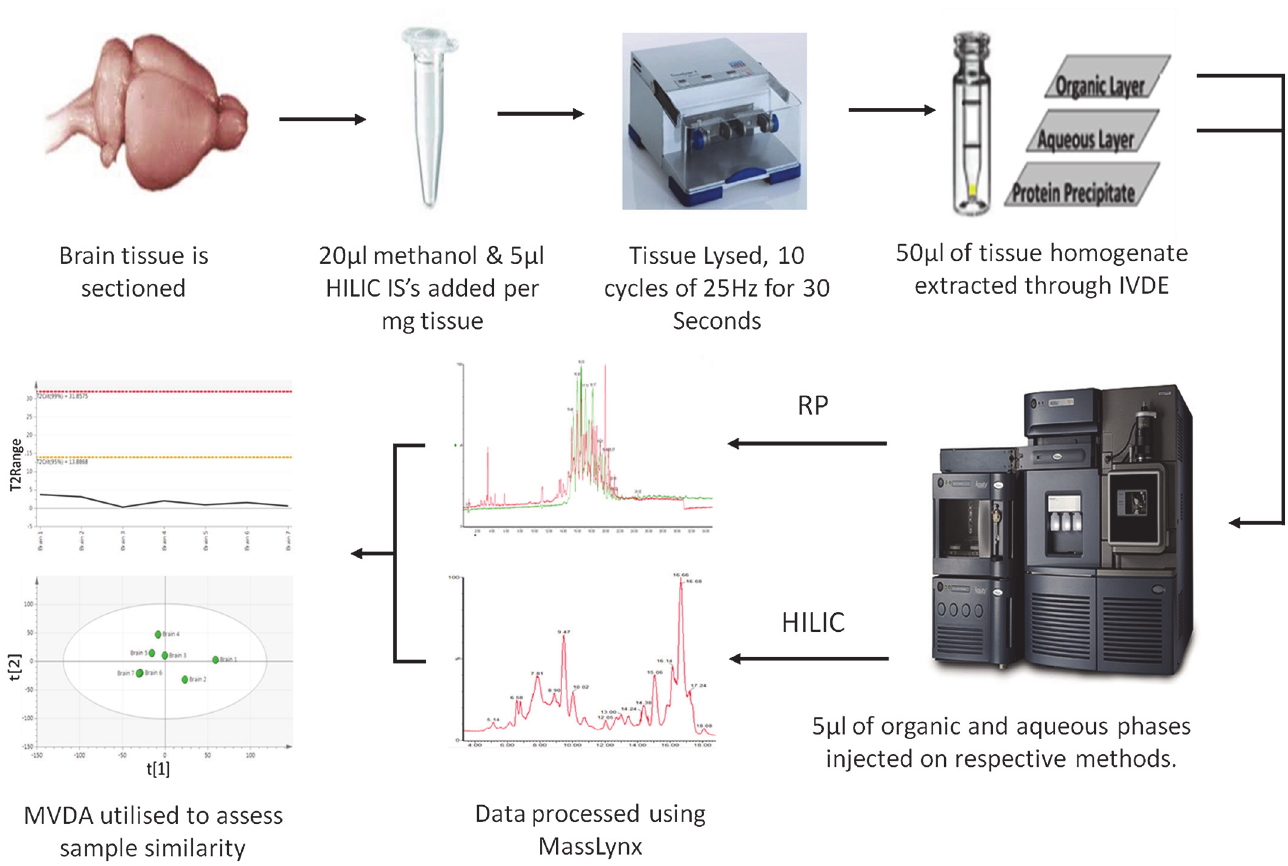
Fig 2. Applied analytical pipeline. Shows the seven steps from tissue sectioning to IVDE and onto data processing and multivariate analysis of variation.